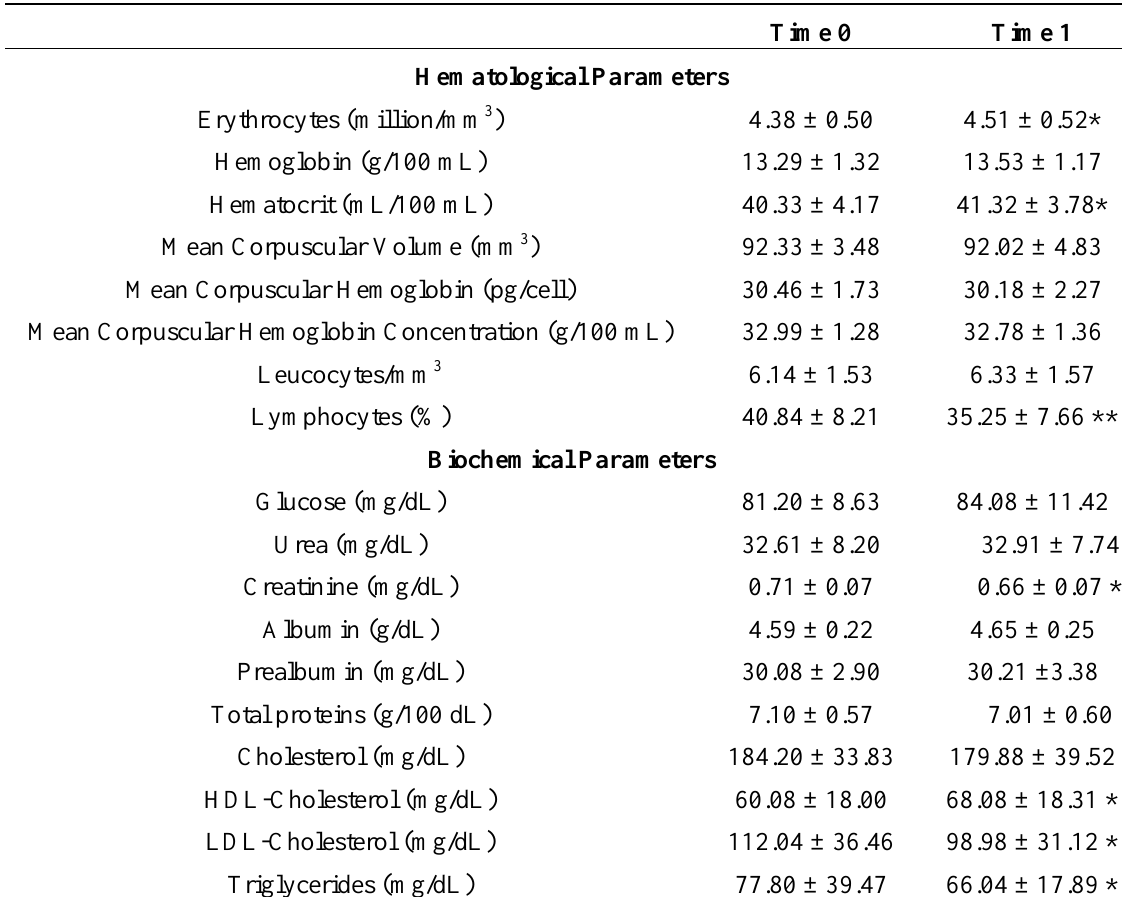
Table 2. Hematological and biochemical parameters at Time 0 and Time